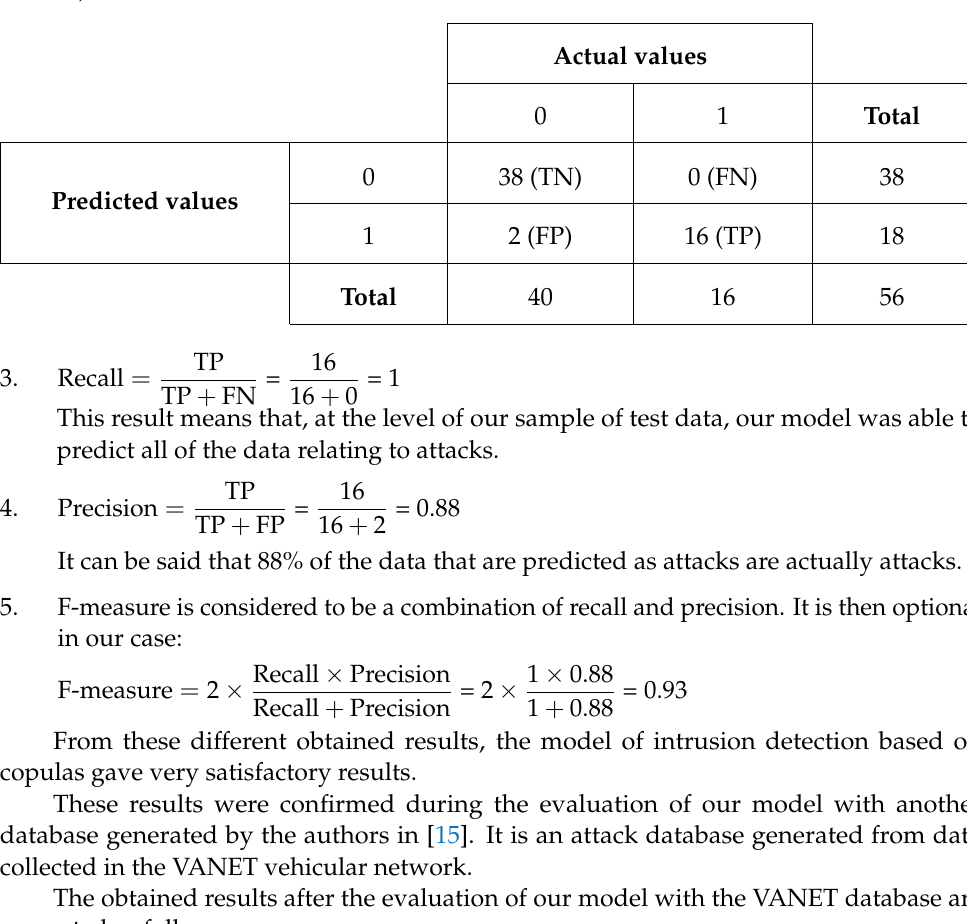
Table 2. Confusion matrix for the V2G network. TN: True Negative; FN: False Negative; FP: False Positive; TP: True